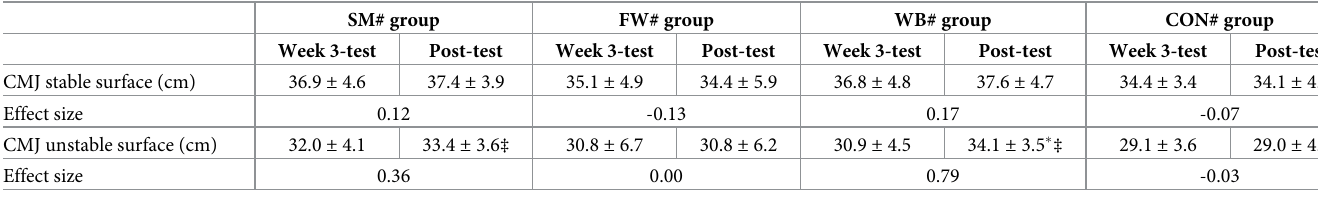
Table 5. Jump height for the groups at week 3 and post-test.